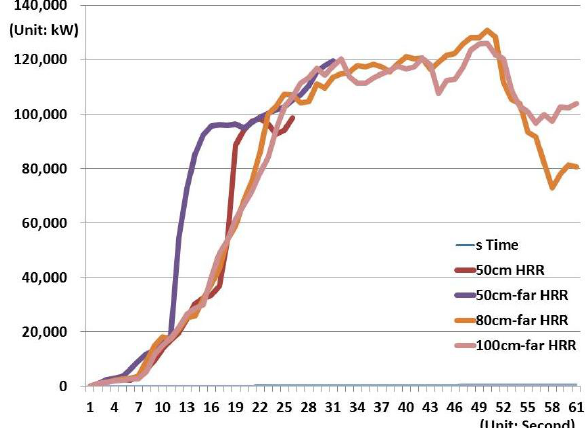
Figure7. The simulation results of heat release rate in different safety